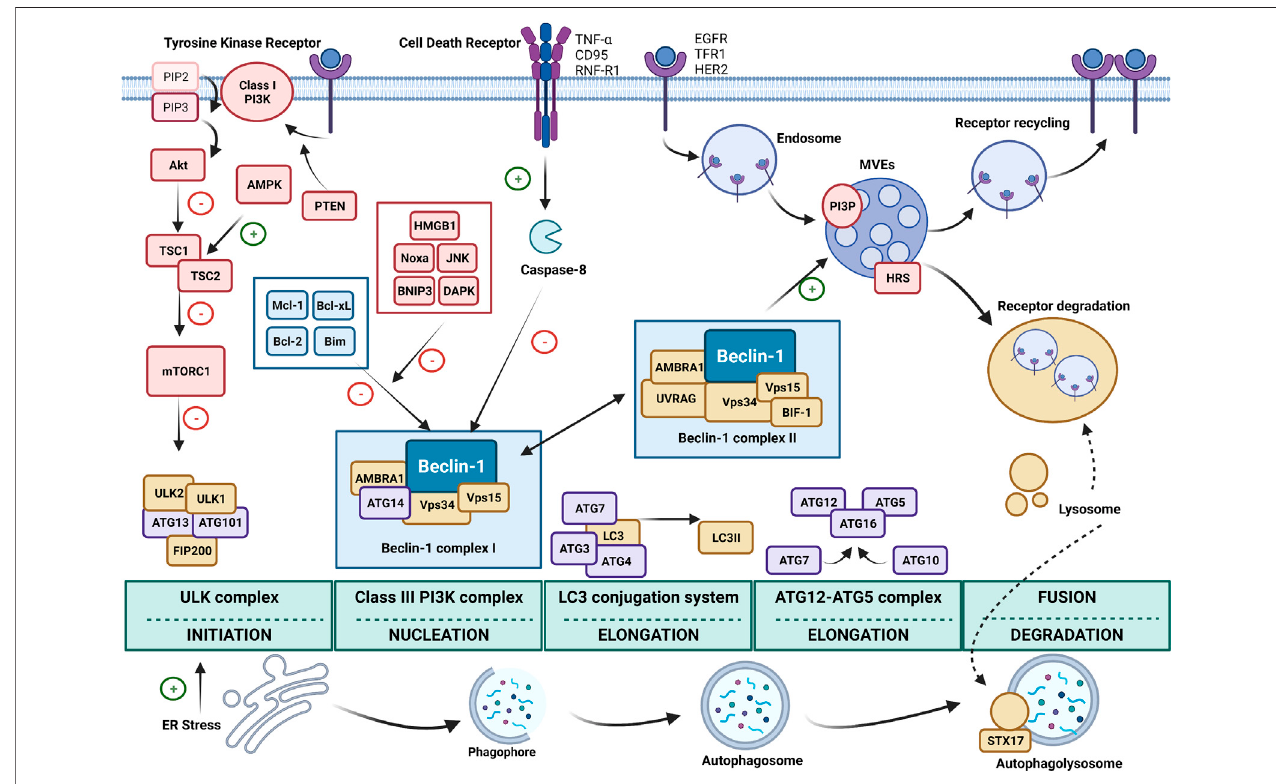
FIGURE 1 | The central role of Beclin-1 during autophagy. Autophagy phases could be divided into: initiation, nucleation and formation of the phagophore, elongationandformationoftheautophagosome,andfusionwiththelysosometoformtheautophagolysosomefordegradation.Theinitiationstepismainlycontrolledby the Unc-51 like autophagy activating kinase (ULK) complex. Endoplasmic reticulum (ER) stress promotes initiation of autophagy activating the ULK complex. Also, mammalian target of rapamycin complex 1 (mTORC1) inhibits autophagy by regulating ULK1 phosphorylation. mTORC1 activity is inhibited by the Tuberous sclerosis complex 1 and 2 (TSC1, TSC2). AMP-activated protein kinase (AMPK) positively regulates autophagy by promoting TSC complex. Furthermore, tyrosine kinase receptors constitute upstream regulators of mTORC1 by promoting Akt activity, which inhibit TSC, by means of phosphatidylinositol (3,4,5)-trisphosphate (PIP3) productionbyphosphatidylinositol-3kinase (PI3K)class I.Thetumor suppressor phosphataseand tensinhomolog (PTEN) promotes thissignaling.Oncetheautophagic induction has been triggered, the class III PI3K complex allows the formation of the phagophore. The Beclin-1 complex is constituted by Beclin-1, ATG14, vacuolar proteinsorting34(Vps34),vacuolarproteinsorting15(Vps15)andautophagyprotein1(AMBRA1).ThiscomplexIspeci fi callyfocusesBeclin-1onautophagicfunctions. Cell death induction by cell death receptor activation leads to caspase-8 cleavage, which ultimately inactivates Beclin-1 so that cells can undergo apoptosis. Beclin-1 interactions with Mcl-1, Bcl-2, Bcl-xL and Bim prevent its association with the pre-autophagosomal membrane, blocking autophagy. This inhibition could be reversed by high mobility group box 1 (HMGB1), c-Jun N-terminal protein kinase 1 (JNK), Noxa, BCL2/adenovirus E1B 19 kDa protein-interacting protein 3 (BNIP3) and death-associatedproteinkinase(DAPK)relatedsignaling.Beclin-1alsodisplaysnon-autophagicpropertieswhenassembledintotheBeclin-1complexII,inconjunction with UV radiation resistance associated (UVRAG), BIF-1, AMBRA1, Vps34 and Vps15. In this complex, Beclin-1 participates in the endosomal pathway of epidermal growth factor receptor (EGFR), transferrin receptor type 1 (TFR1) and HER2. Receptors could be internalized into endosomes and sorted to multivesicular endosomes (MVEs). Togetherwith phosphatidylinositol3-phosphate (PI3P) production and recruitment ofhepatocyte growth factor tyrosine kinase substrate (HRS).Beclin-1promotes degradation of receptors after fusion with lysosomes. Otherwise, in the absence of Beclin-1, receptors would be recycled to the plasma membrane to promote survival. Beclin-1 pivots between both complexes to promote anti-tumoral functions. Other two complexes participate in the elongation of the pre-autophagosomal membrane: the LC3 conjugation system and the ATG12-ATG5 system. After formation, the autophagosome fuses with lysosomes, where syntaxin 17 (STX17) plays a major role.